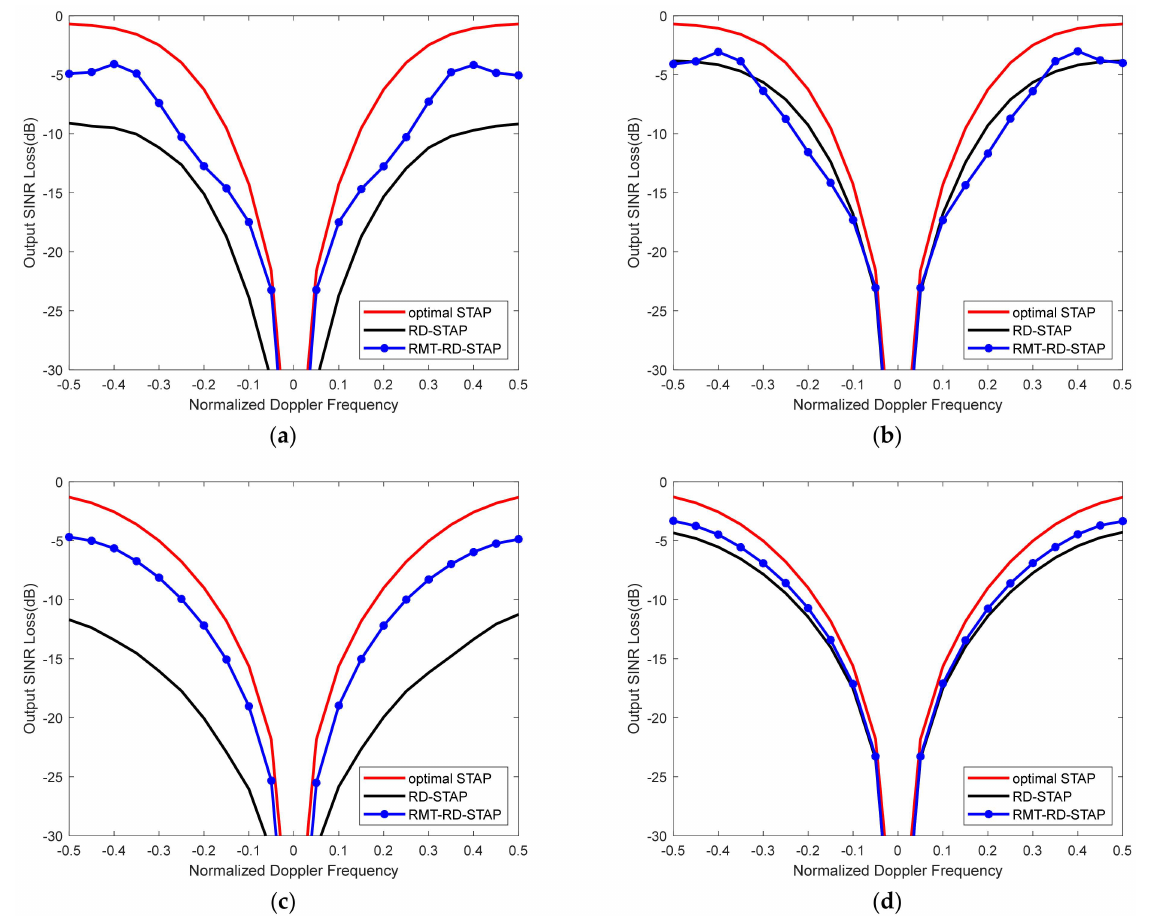
Figure 8. Output SINR losses versus normalized Doppler frequencies with 2% ICM. ( a ) V = 150 m/s, L = M ; ( b ) V = 150 m/s, L = 2 M ; ( c ) V = 300 m/s, L = M and ( d ) V = 300 m/s, L = 2 M .